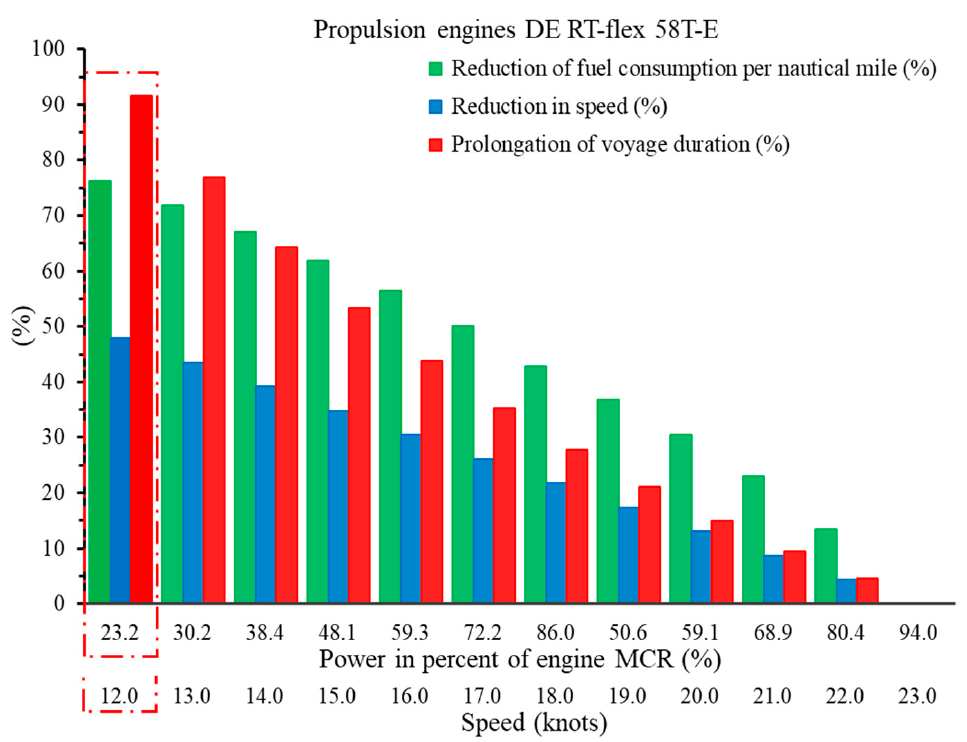
Figure 13. Propulsion with two low-speed diesel engines—Con fi guration 2.